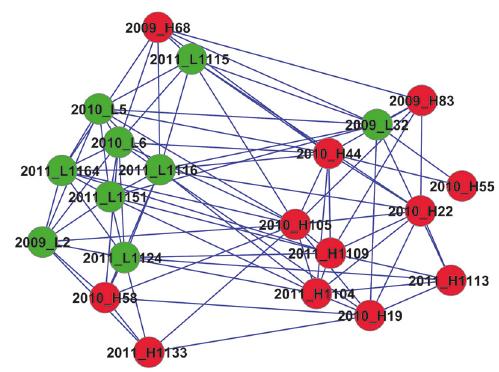
Figure 3: Additional validation of the 207 transcripts biomarker. The graph represents samples classification by means of the 207 transcripts biomarker of subjects included in the testing group of [11], which is related to the TIV vaccination campaigns of 2009, 2010, and 2011 (set #3). Nodes represent subjects and the length of connecting edges is proportional to the distance between subjects’ signatures. Node colors indicate subjects’ class (green for low responders and red for high responders). Node labels indicate the year of the vaccination campaign, sample class (H for high responders and L for low responders), and sample identifier. Four out of 21 subjects were misclassified (subjects 2009 H68, 2010 H58, 2011 H1133, and 2009